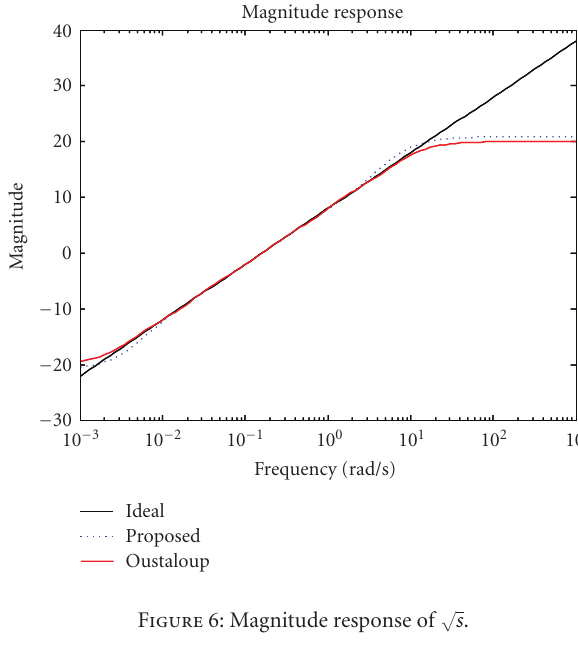
Figure 6: Magnitude response of